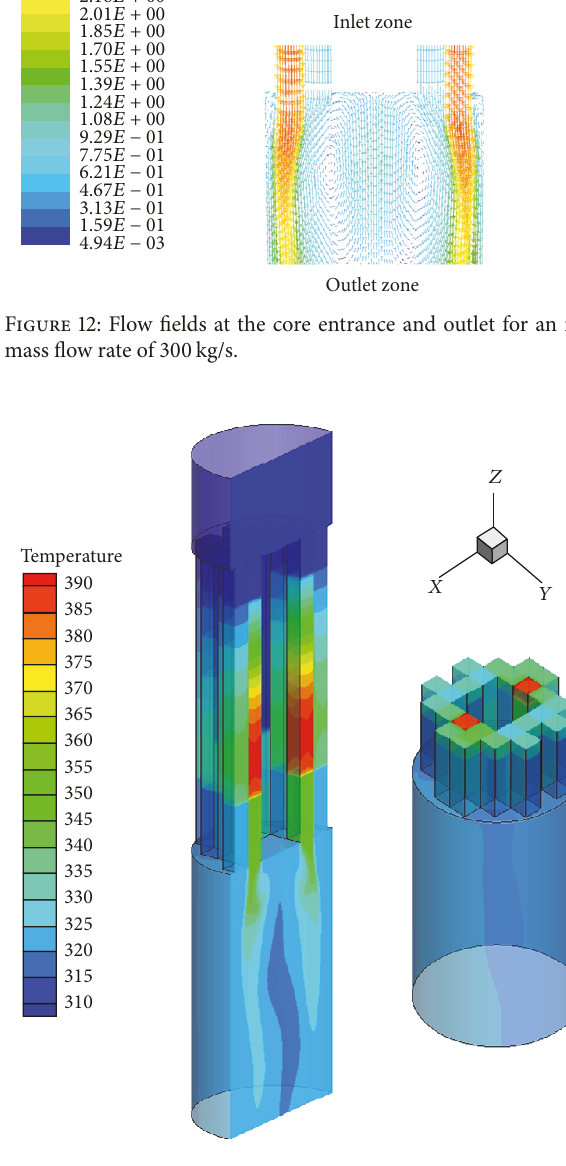
Figure 13: Temperature distribution in the core at an inlet mass flow rate of 400